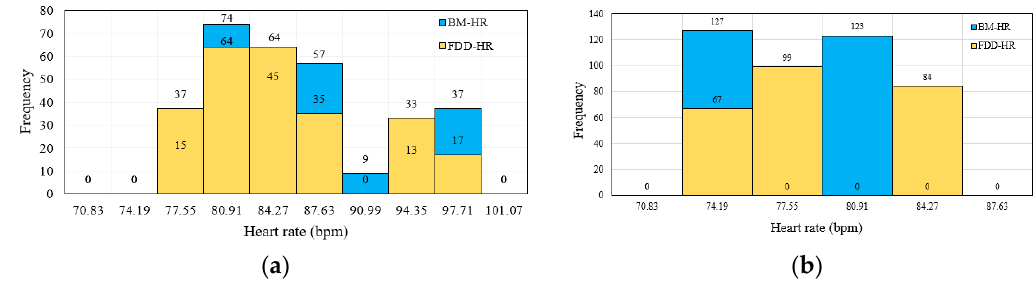
Figure 13. Histogram analysis of HR data measured from both the FDD and BM devices for ( a ) adult volunteers, and ( b ) elderly volunteers.